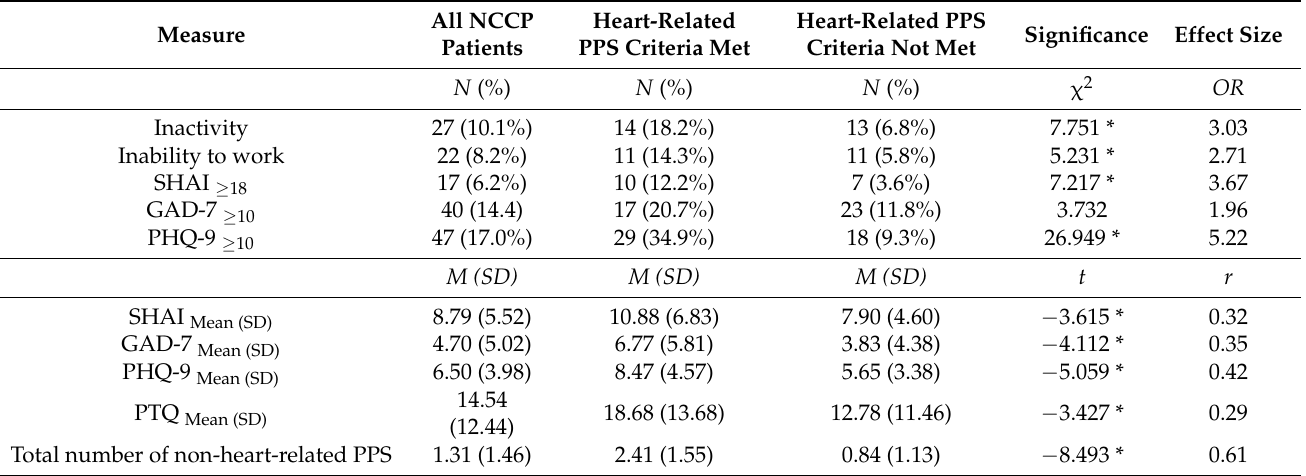
Table 2. Comparisons of working status, rumination and symptoms of anxiety, depression and health anxiety between NCCP patients that did and did not meet criteria for heart-related PPS.